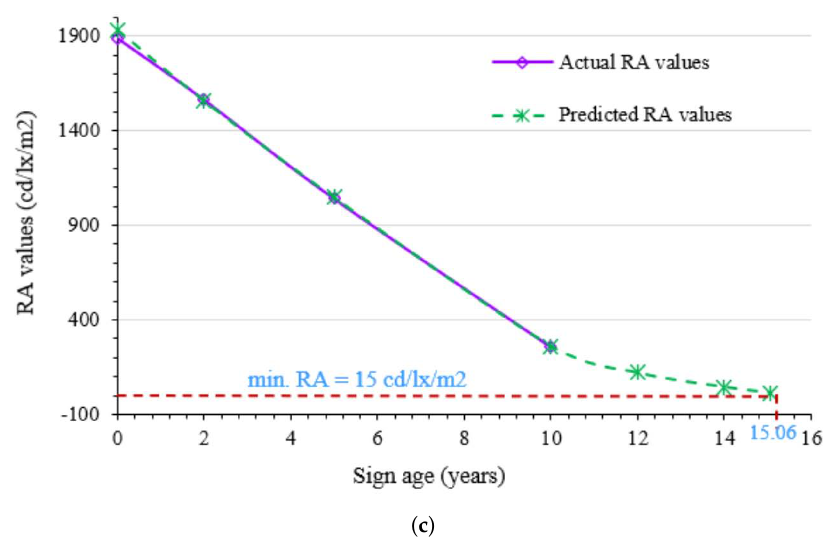
Figure 7. Example plots showing retro-reflectivity values as a function age for sample traffic signs in different colors. ( a ) Color = White, ( b ) Color = Green, ( c ) Color =